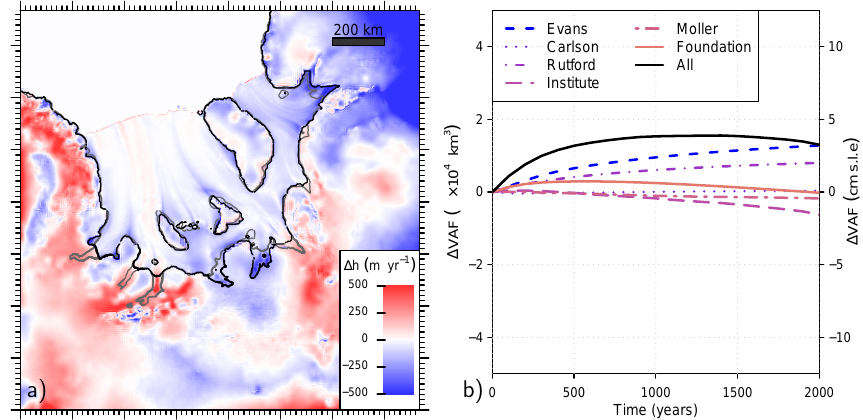
Figure 5. (a) Map showing total change in ice thickness (colour scale) and grounding line position over a 2000-year model run (grounding line in grey, t = 0 years; black, t = 2000 years). (b) Plot of volume above flotation change (km 3 ) against time for each of the ice stream catchments. The solid black line is the cumulative combined volume change for all six ice